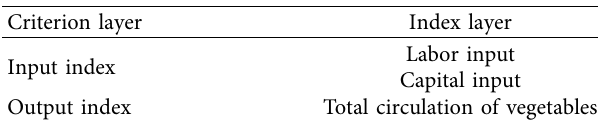
Table 1: Evaluation index system of vegetable circulation efficiency in Henan